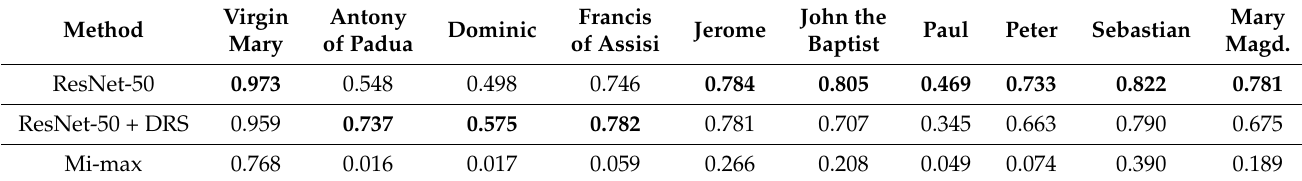
Table 4. Per-class classification performance on ArtDL 2.0 —This table presents the per-class AP results on the ArtDL 2.0 data set. The best-performing method for each class is highlighted in